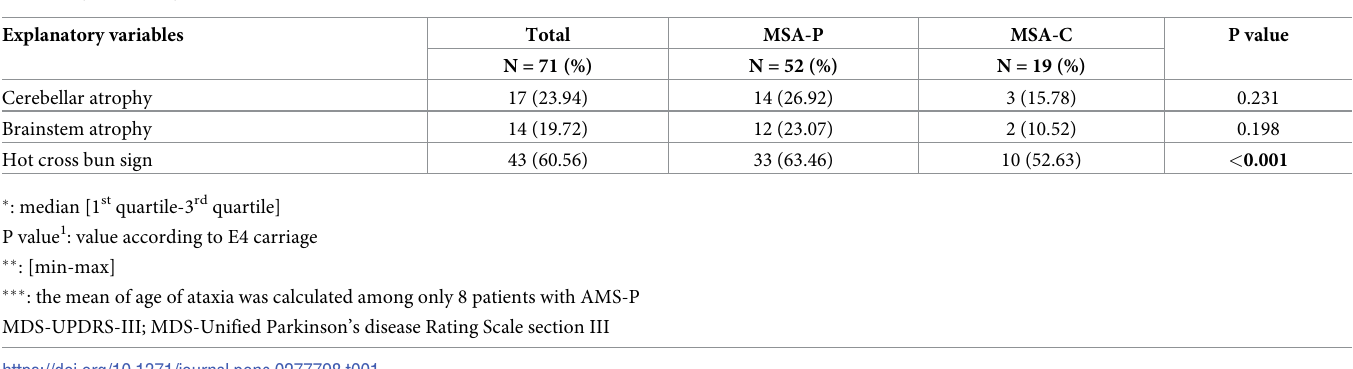
Detailed neuropsychological characteristics of the total study population and across motor subtypes are summarized in Table 3 and illustrated in Figs 1 and 2.